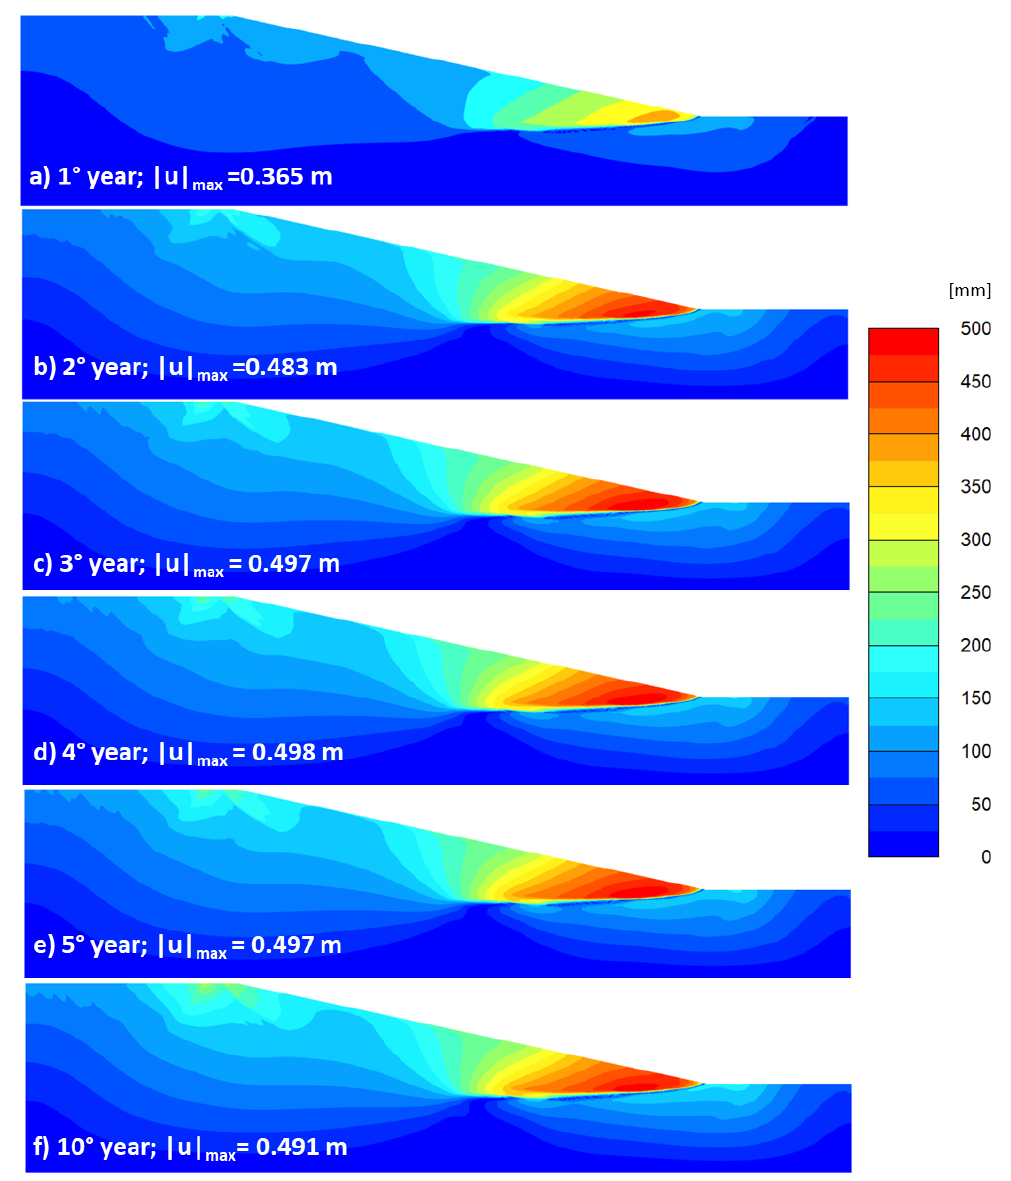
Figure 15. Analysis F: evolution of the progressive failure due to the SLVA interaction in terms of displacements during the 10 years of net rainfall; the total displacements refer to the end of the first, second, third, fourth, fifth and 10th years. Figures from a ) to f ) correspond to the results at the end of the 1st, 2nd, 3rd, 4th, 5th, and 10th year of analysis.